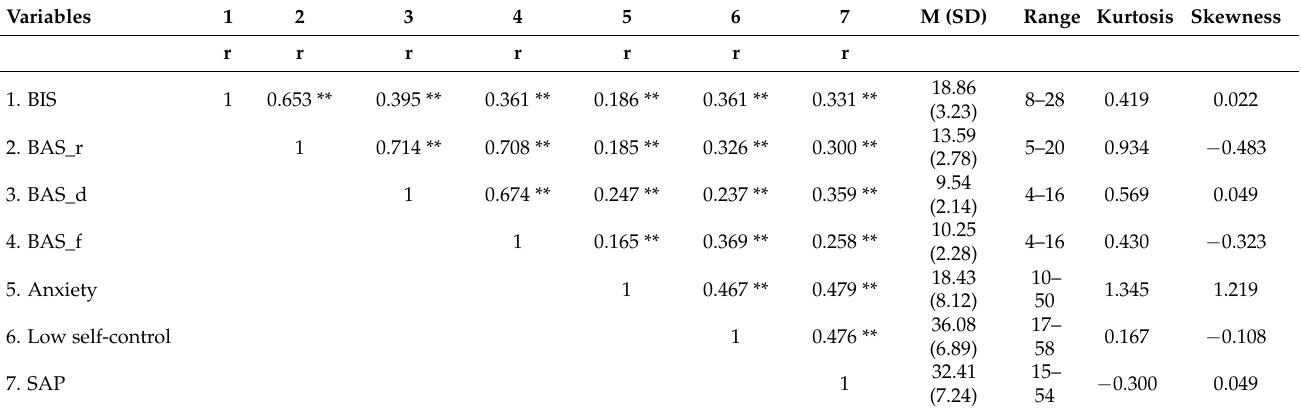
Table 3. Correlation coefficients, means, and standard deviations of the study variables ( n =